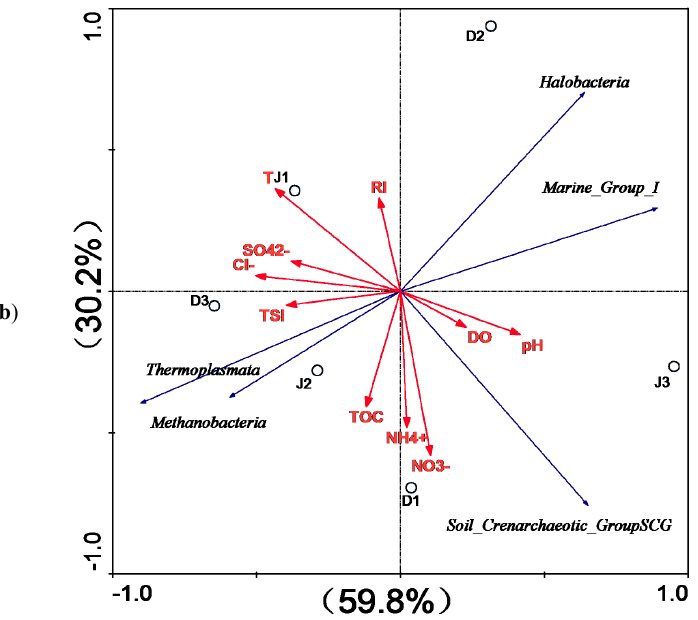
Figure 9. RDA for the first two principal dimensions of the relationship between ( a ) bacterial and ( b ) archaeal OTUs and environmental factors.